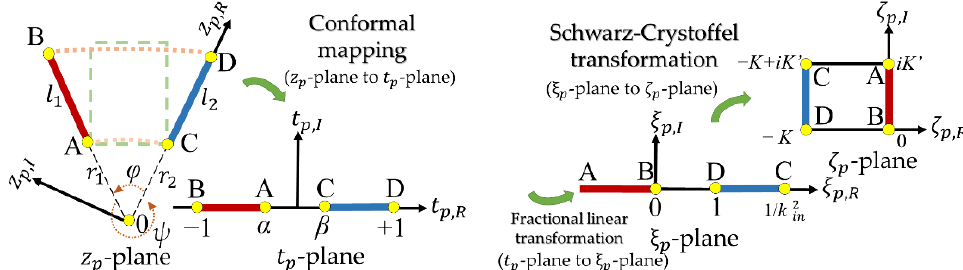
Figure 3. Conformal mapping transformation process for two electrodes per unit longitudinal length. First, the cross-section of the inclined-plate capacitor of the ring on the membrane ( z p -plane) is mapped onto the upper half plane ( t p -plane). Second, the t p -plane is mapped onto the ξ p -plane through fractional linear transformation. Third, the ξ p -plane is mapped onto the ζ p -plane through the Schwarz-Crystoffel transformation.